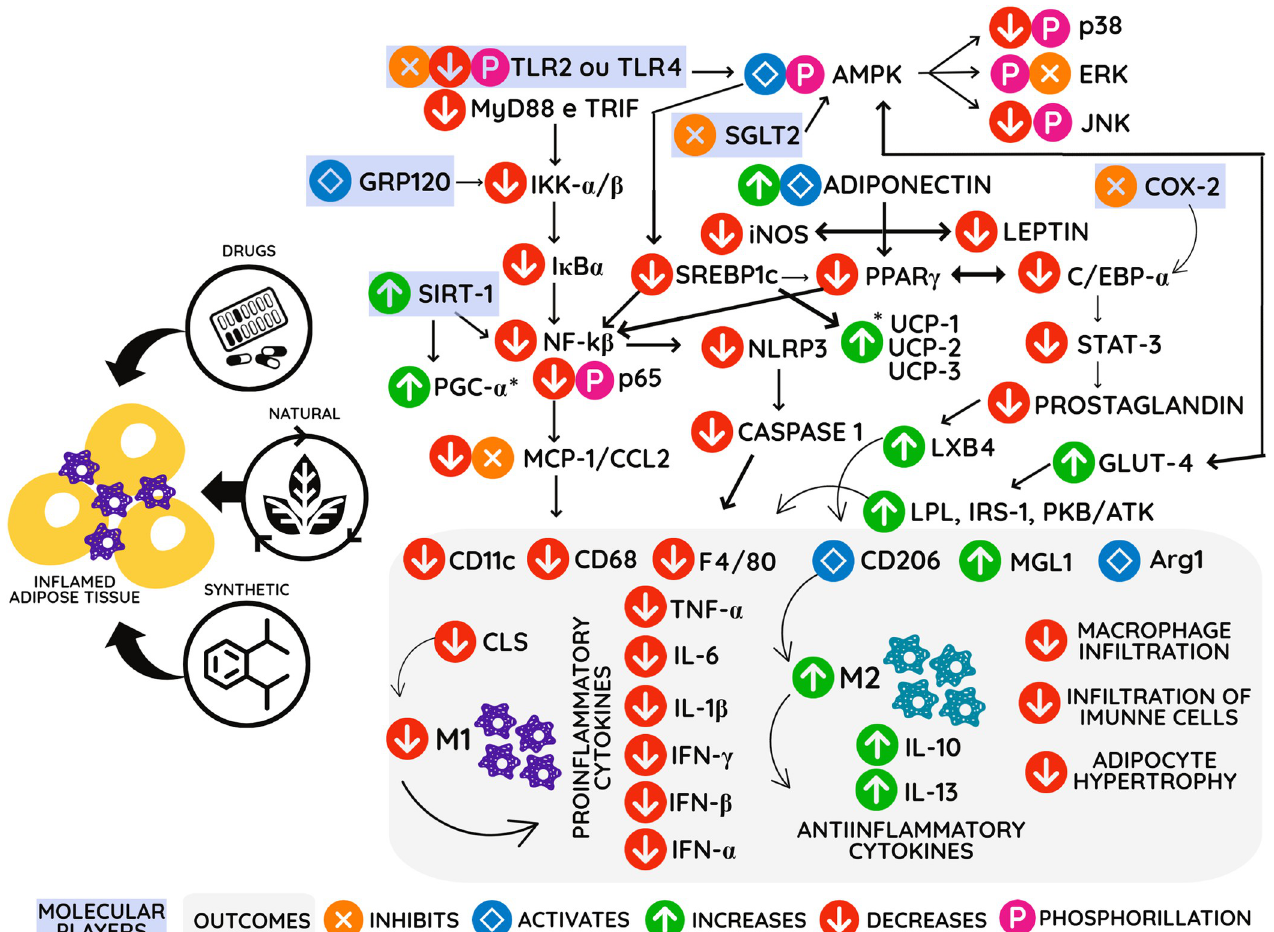
Fig 3. Mechanisms of action of anti-inflammatory agents in adipose tissue on the expression of genes and proteins in a hypothetical cell. Anti- inflammatory agents (Drugs, natural and synthetic compounds) act in several ways that cross and culminate in reducing infiltration of immune cells, reducing the pro-inflammatory profile, and changing the M2 and M1 polarization, inducing an anti-inflammatory profile and suppressing inflammation in obesity. COX2: cyclooxygenase enzyme. TNF- α : tumor necrosis factor-alpha. PPAR- γ /2: peroxisome proliferator-activated gamma receptors. CEBP- α : CCAAT- enhancer-binding proteins. SREBPc: sterol regulatory element-binding proteins. TLR2/4: toll-like receptors. MyD88: myeloid differentiation primary response gene 88. JNK: c-Jun N-terminal kinases. iNOS: induced nitric oxide synthase. MGL-1: macrophage galactose-type lectin 1. NOX4: NADPH oxidase 4. FoxO1: Forkhead Box O1. STAT3: Signal transducer and activator of transcription 3. NLRP-3: NLR family pyrin domain containing 3. FAS: Fas cell surface death receptor. INF α / β : interferons. IL-1, IL- 6, IL-10, IL-13: interleukins. MCP-1: monocyte chemoattractant protein-1. NF-k β : nuclear factor-kappa β . CLS: crown- like structures. LPL: lipo-protein lipase. IRS-1: insulin receptor substrate 1. GLUT-4: glucose transporter. LXB4: lipoxin A4. ARG-1: arginase 1. AMPK: AMP- activated protein kinase. UCP-1/2/3: uncoupling protein. SGLT2: sodium/glucose cotransporter 2.